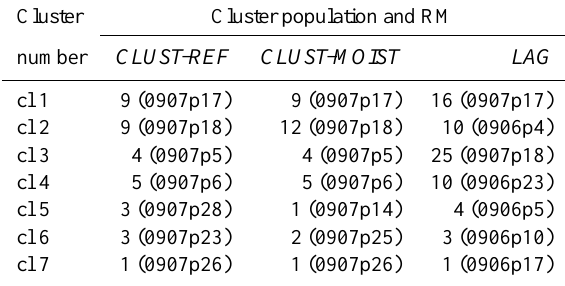
Table 1. Var case population and RMs for the CLUST-REF , CLUST- MOIST and LAG ensembles: columns 2, 3 and 4, respectively. The clustering time is 00:00UTC on 15 June 2010. The RMs (in paren- thesis) are expressed as MMDD “p”nn, where nn indicates the per- turbed element of the ensemble started on day DD. See also text for more details.